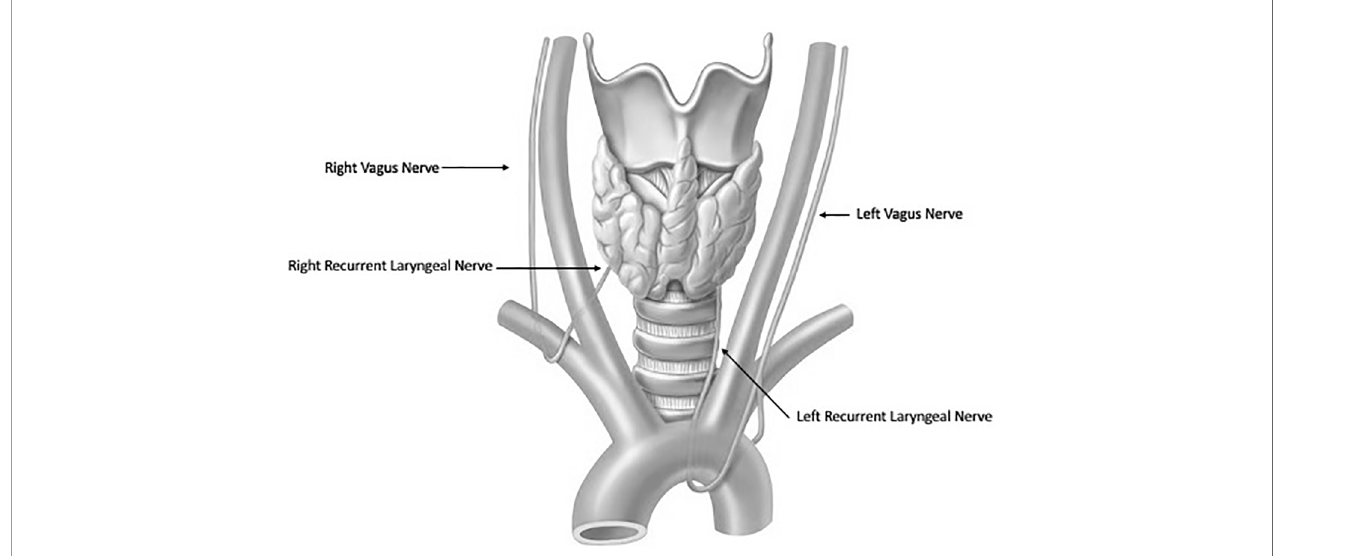
FIGURE 1 | Anatomy of the Recurrent Laryngeal